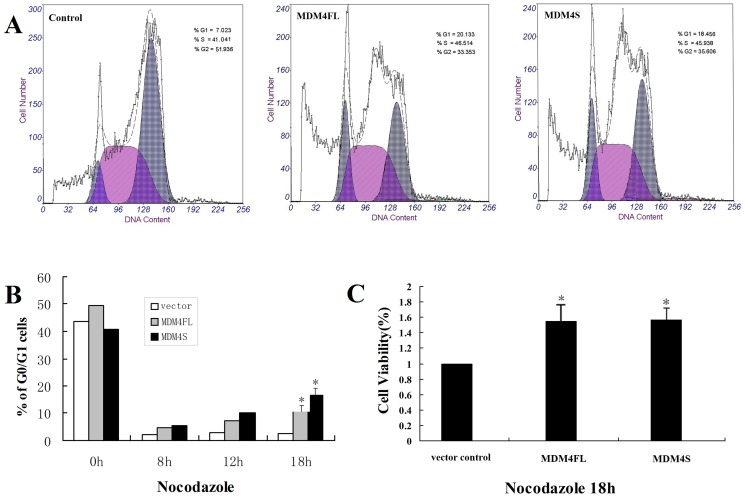
Cell cycle and cell proliferation analysis.A: DNA content detected by flow cytometry in MDM4FL, MDM4S-expressing or control cells. B: The proportion of G0/G1 phase cells at different time points after Nocodazole treatment. C: Cell proliferation assay. The average percentage of proliferating cells was increased in MDM4FL and MDM4S-expressing cells. *P<0.05.